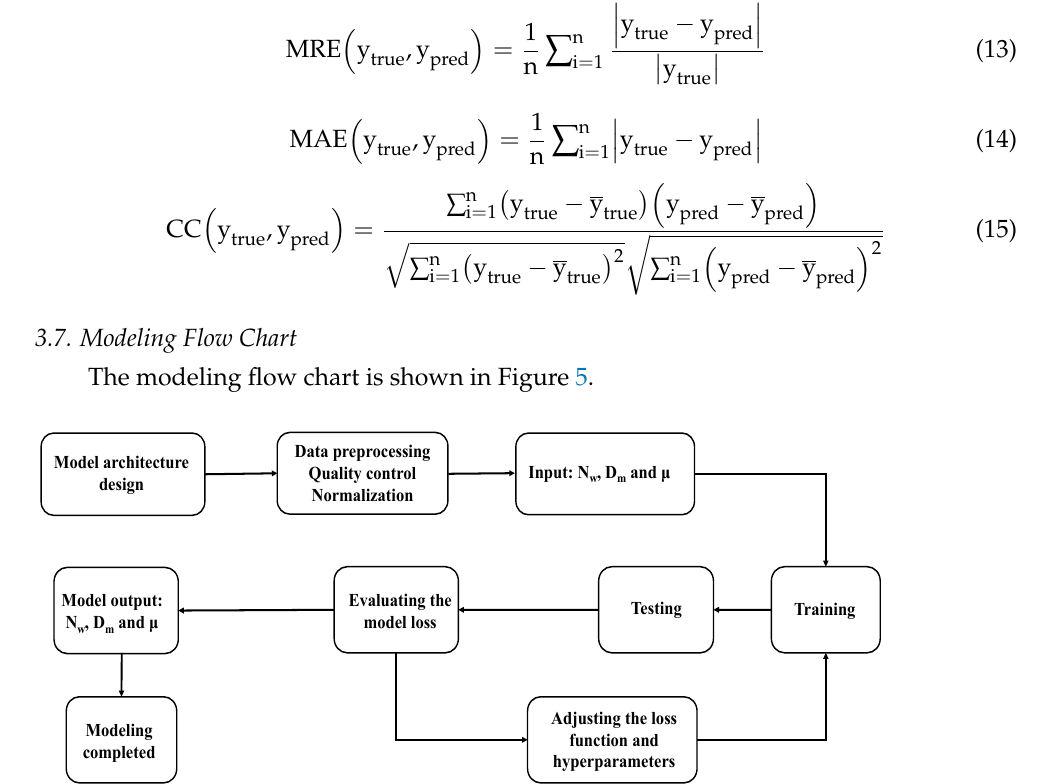
Figure 5. The modeling flow chart.